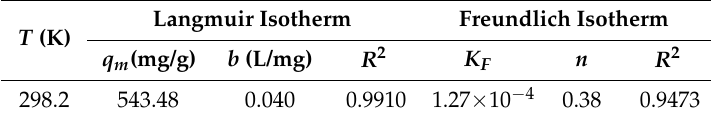
Table 1. Parameters of langmuir and freundlich models for Pb(II) removing by MIL-101-TEPA@CA. Langmuir Isotherm T (K)